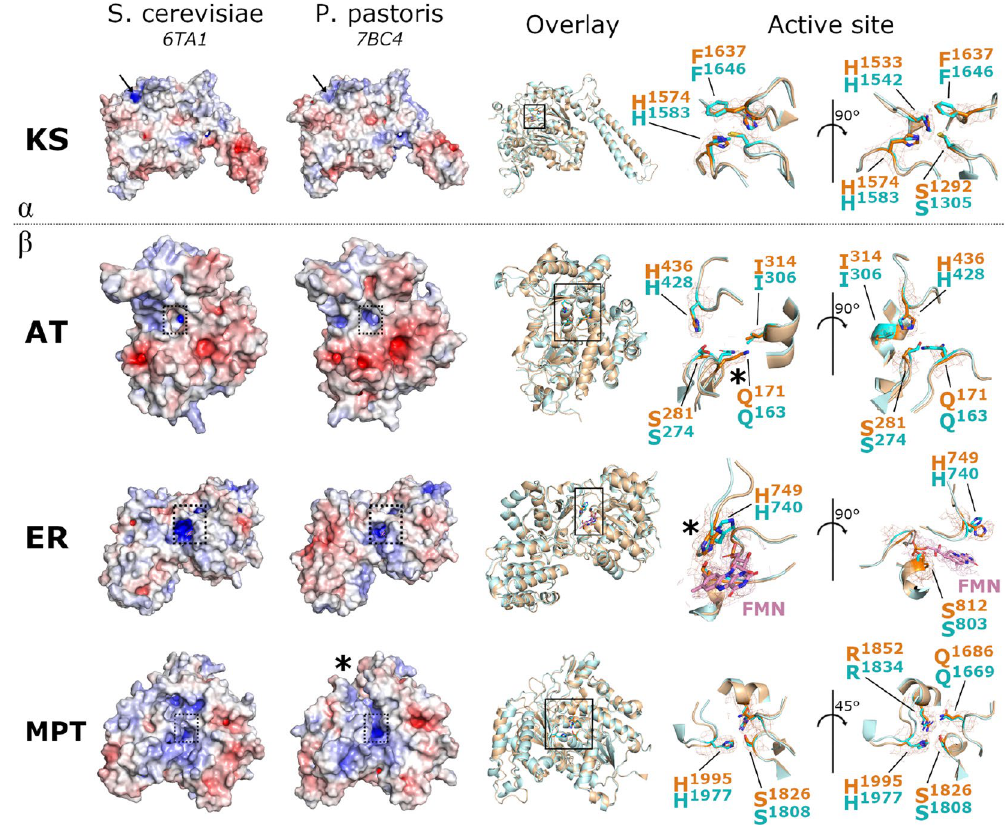
Figure 4. Structural details of key FAS enzymatic domains. For each key enzymatic domain (KS—ketoacyl synthase, AT—acetyl transferase, ER—enoyl reductase, MPT—malonyl/palmitoyl transferase), surfaces are shown for both P. pastoris FAS and S. cerevisiae FAS (PDB 6TA1 20 ), coloured according to electrostatic charge (blue—positive, red—negative). The locations of the active sites are highlighted by dashed boxes (AT/ER/MPT) or black arrows (KS). An overlay of the atomic models is also shown ( P. pastoris FAS—orange, S. cerevisiae FAS—blue) with enlarged images of key active site residues (located within the solid boxes). Density for P. pastoris FAS is shown around highlighted active site residues. FMN and corresponding EM density is shown in pink. Key differences are highlighted by asterisks (Q171 in the AT domain, H749 in the ER domain, MPT subdomain